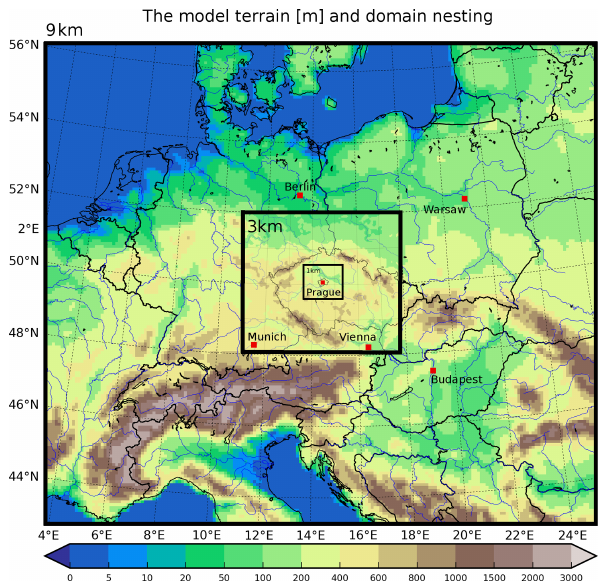
Figure 1. The resolved model terrain in meters, the nesting struc- ture and the cities analyzed in the study (Prague, Berlin, Munich, Vienna, Budapest and